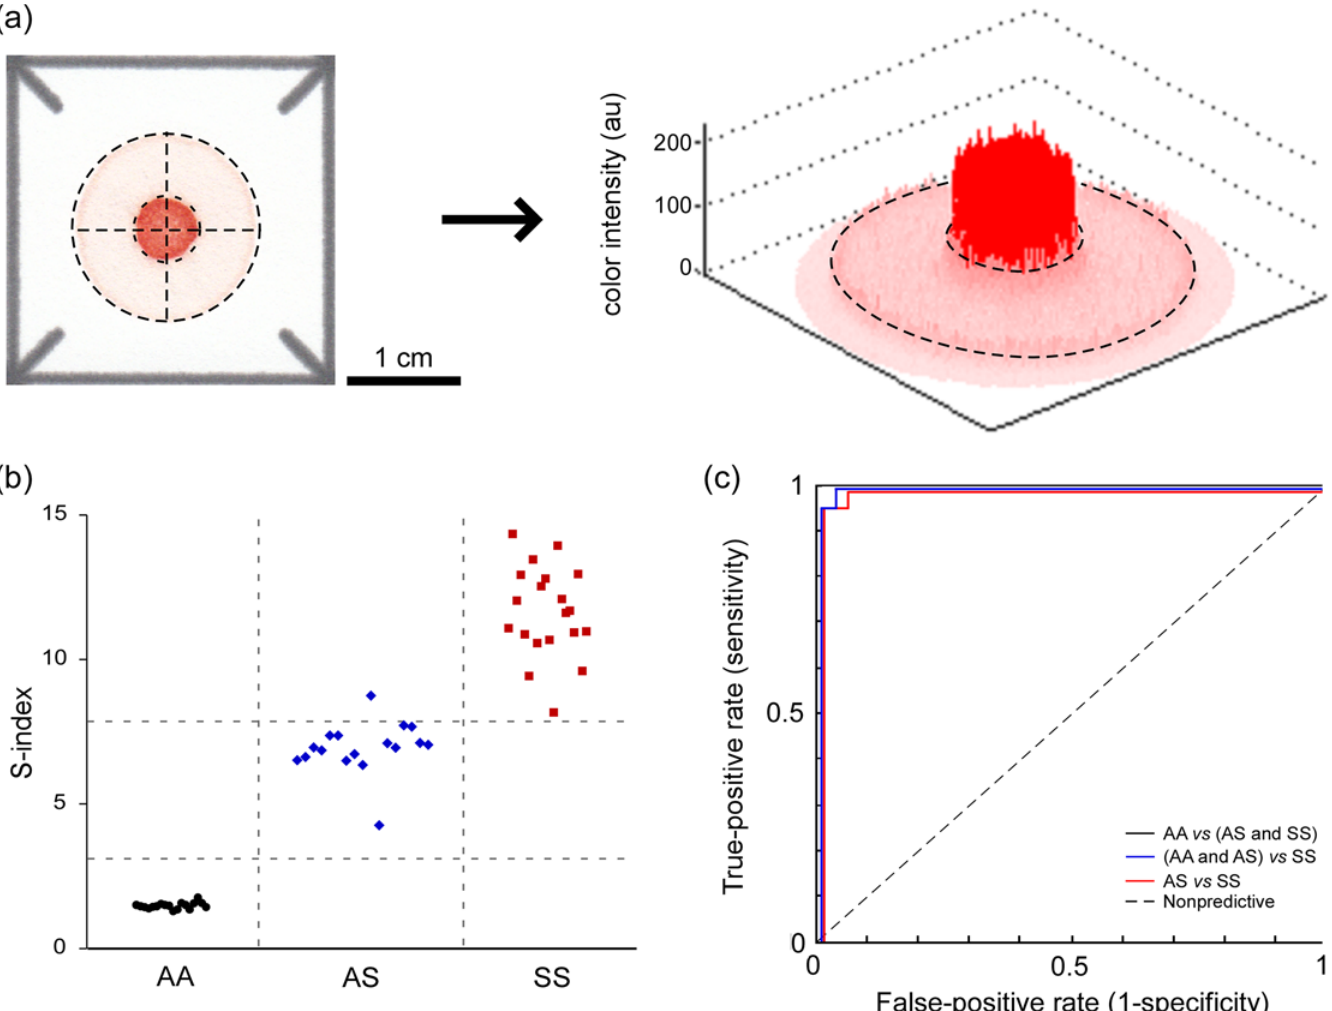
Fig 3. Automated analysis of blood stains in paper. ( a ) A custom image analysis algorithm automatically detected the center of each blood stain (dashed crosshair) and extracted the RGB values for all pixels contained within the dark red center spot (smaller dashed circle) and within the pink peripheral ring (area between the smaller and the larger dashed circles). The S-index was defined as the quotient of the mean red color intensity of the center spot and that of the peripheral ring of the blood stain. ( b ) The values of the S-index for ( ● ) HbAA (n = 18), ( ♦ ) HbAS (n = 17) and ( ■ ) HbSS (n = 20) samples obtained from healthy subjects and patients in New Orleans, LA. ( c ) Receiver operating characteristic (ROC) curves for the use of S-index to identify HbAA, HbAS and HbSS samples. The area under the curve (AUC) for discriminating HbAA from HbAS and HbSS was 1.00, the AUC for discriminating HbSS from HbAA and HbAS was 0.9986 and the AUC for discriminating HbSS from HbAS was